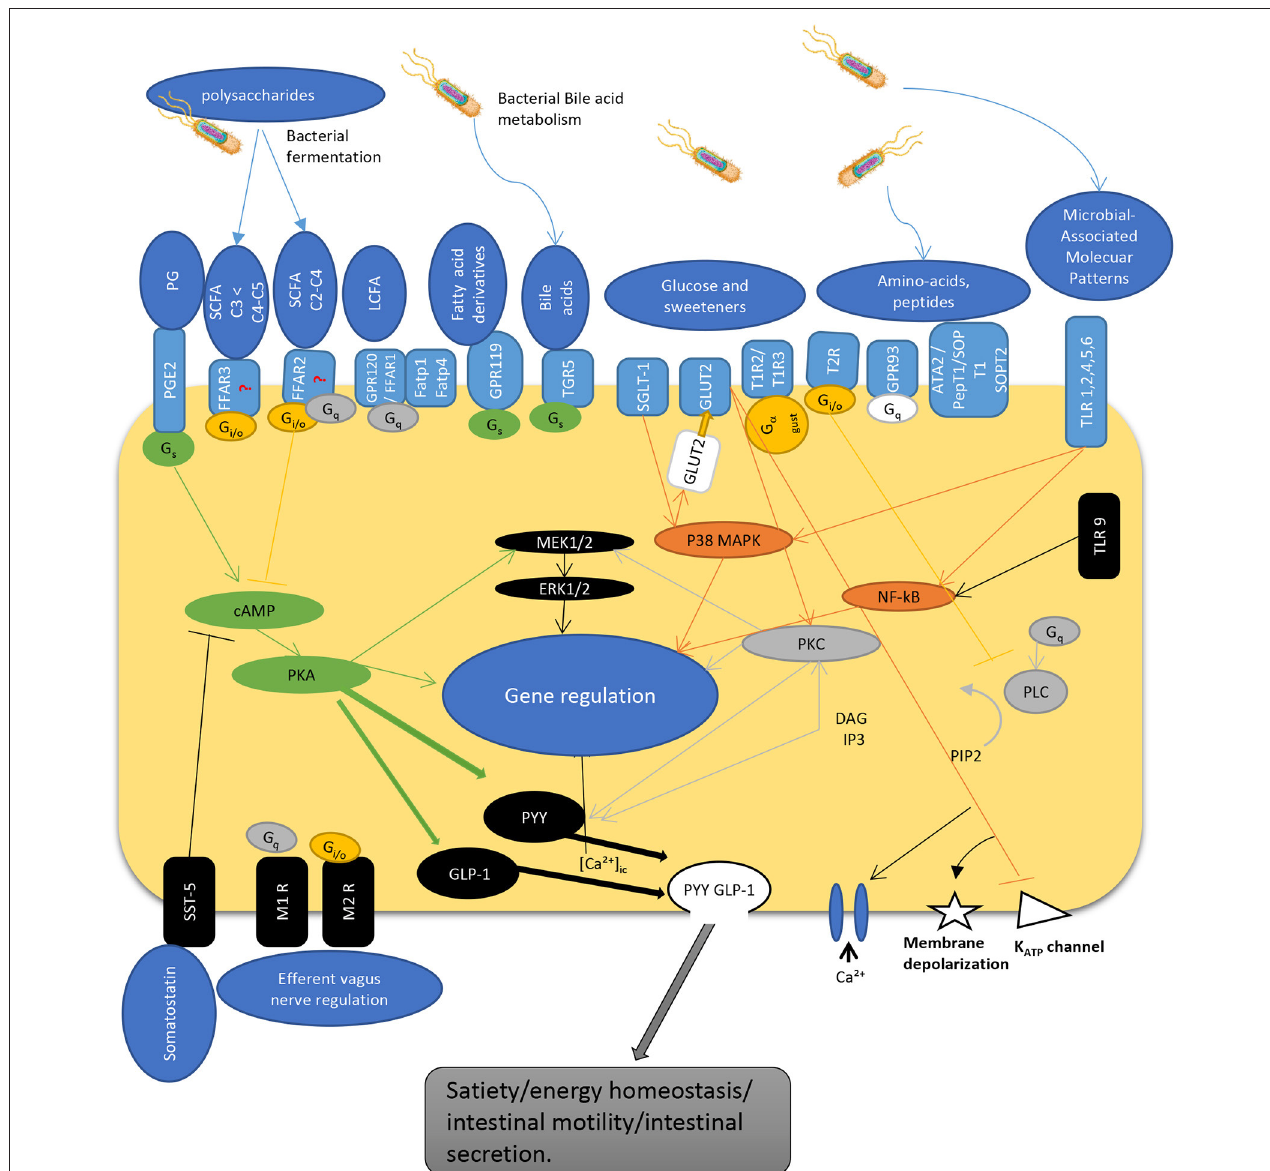
FIGURE 1 | Schematic overview depicting regulatory pathways for PYY and GLP-1 secretion by enteroendocrine L-cell. The L-cells express a wide variety of GPCRs that sense luminal content including dietary and bacterial products. SCFAs are recognized by FFAR2 and FFAR3 expressed at the apical and basolateral membrane [but see (47)]. G s activates adenylyl cyclase, increases cyclic AMP, activation of PKA that regulate gene expression, and activates GLP-1 and PYY. G protein G i / o inhibits G s cAMP pathway while activating PLC pathway. Similarly, G q activates PLC pathway to hydrolysate PIP2 into DAG and IP3. IP3 induces intracellular Ca 2 + release mediated by voltage-gated Ca2 + channels. DAG activates PKC, an important regulator of cell activity and gene expression. Hormone secretion is also stimulated by the Gs-coupled GPR119 and TGR5. TLRs sense microbial molecules and mediate inflammatory responses through NF-kB pathway. Glucose sensing implicate transporters that act through inhibition of K ATP channels inducing membrane depolarization and calcium entry into the cell. These pathways enable L-cells to communicate with other cells by secreting gut peptides like GLP-1 and PYY, as well as by regulating their expression. PG, prostaglandins; SCFA, short chain fatty acids; LCFA, long chain fatty acids; TLR, toll-like receptor; PGE2-R, prostaglandin E2-receptor, FFAR, free fatty acid receptor; GPCR, G-protein coupled receptor; FATP, fatty acid transport protein; TGR, membrane-type receptor for bile acids; SGLT, sodium glucose transporter; GLUT, glucose transporter; T1R/T2R, taste receptor; ATA, aurintricarboxylic acid; pepT, peptide receptor; SOP, serine-o-posphate receptor; cAMP, cyclic adenosine monophosphate; G s , G i / o , G q , G-protein subunits; MEK, mitogen-activated protein kinase kinase; ERK, extracellular signal-regulated kinase; MAPK, mitogen-activated protein kinase; PKC, protein kinase C; NF-kB, nuclear factor kappa beta; PLC, phospholipase C; GLP-1, glucagon-like peptide; PYY, peptide YY; DAG, diacyl glycerol; IP3, inositol triphosphate; PIP2, phosphatydilinositol (4,5) diphosphate; K ATP , adenosine triphosphate sensitive potassium channel; SST, somatostatin receptor; M1R/M2R, muscarinic receptor; [Ca 2 + ] ic, calcium internal concentration.